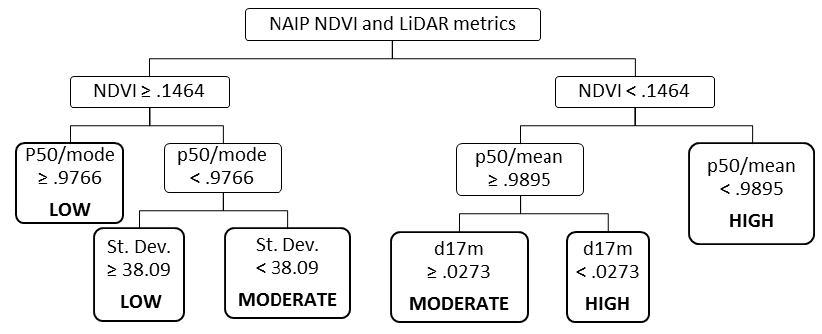
Figure 6. Classification tree for Model B, imagery and post-fire LiDAR.